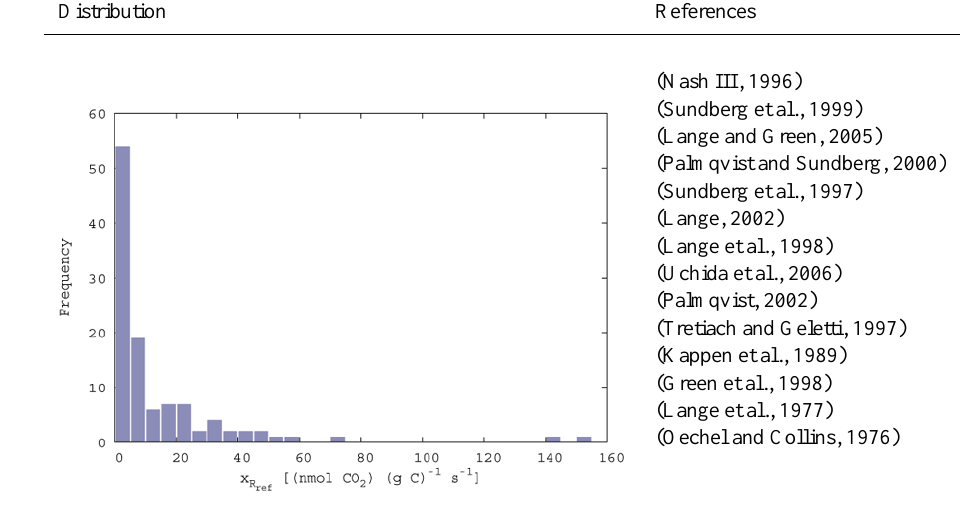
Fig. B6. Overview of the distribution of the reference maintenance respiration rate at 10 ◦ C, x R